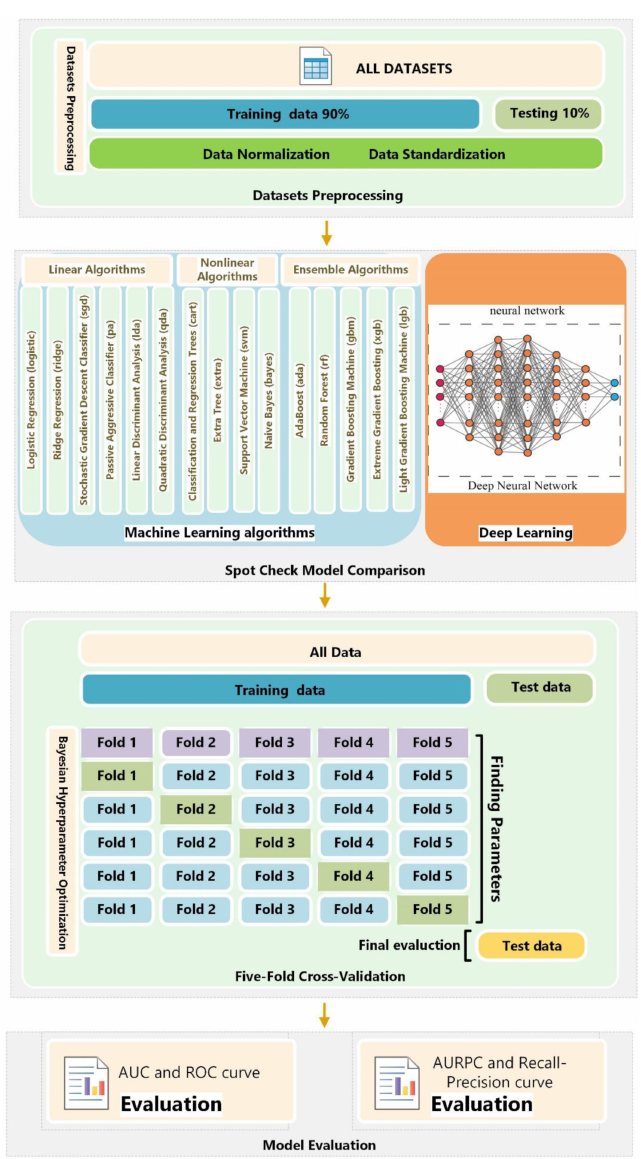
Figure 3. The flowchart of the proposed machine learning